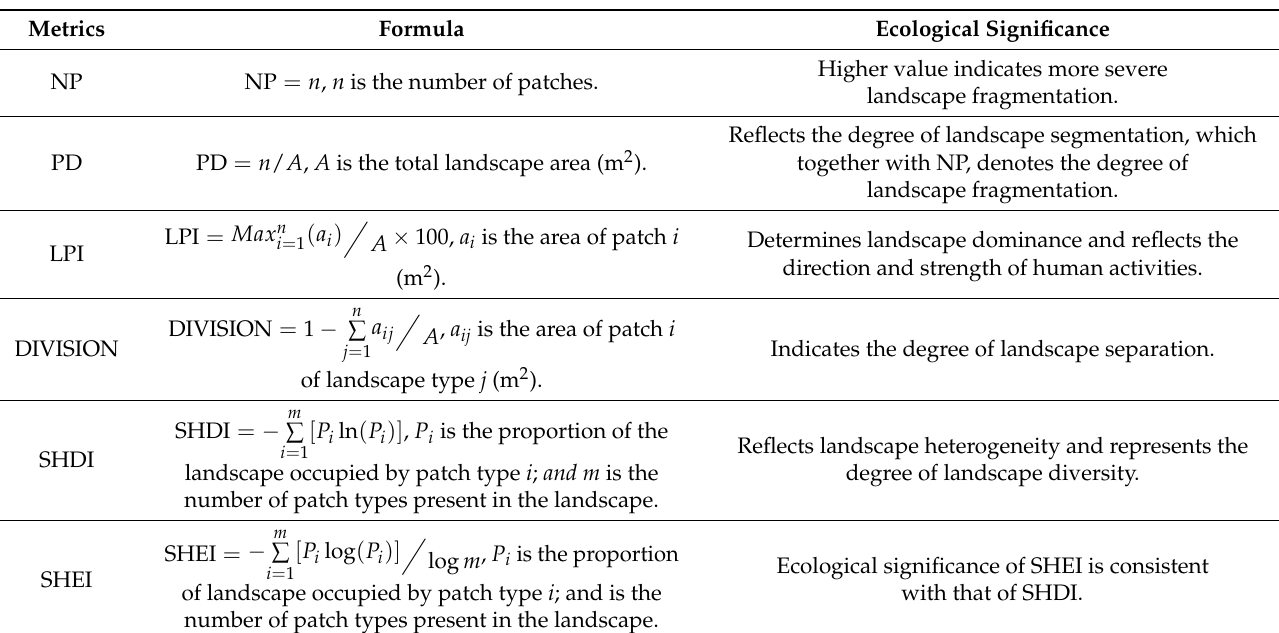
Table 3. Calculation method and ecological significance of selected landscape metrics. Metrics